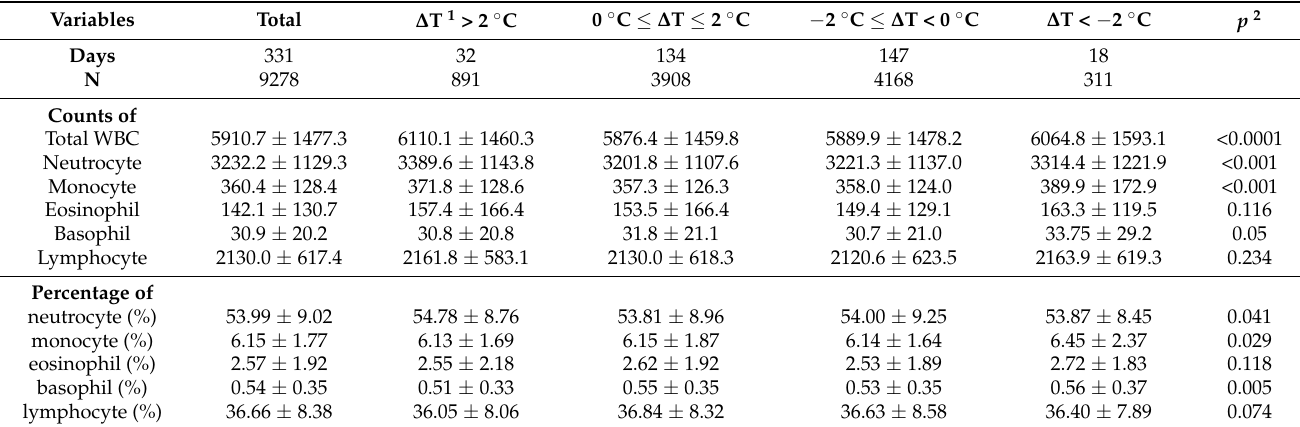
Table 2. Counts and percentage of WBCs by different value of Δ T.